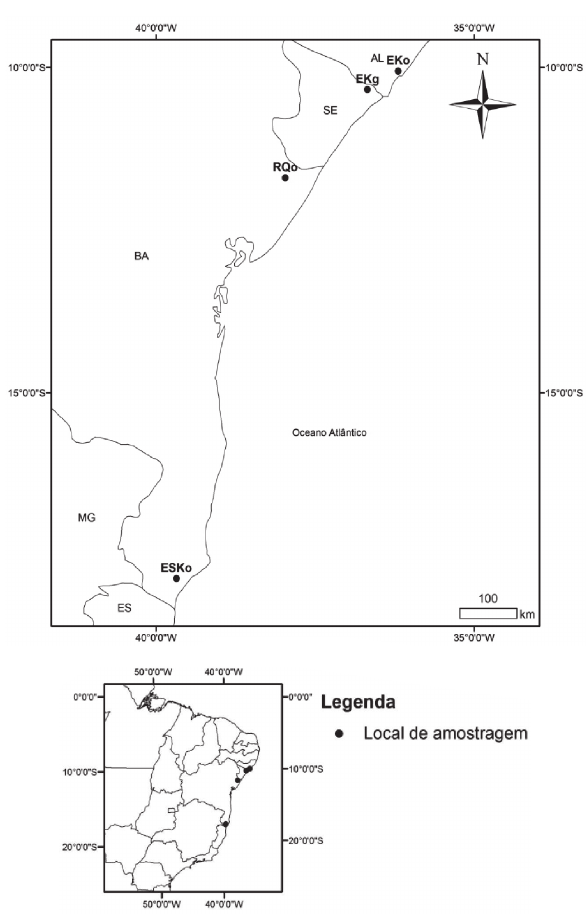
Figura 1. Localização dos solos